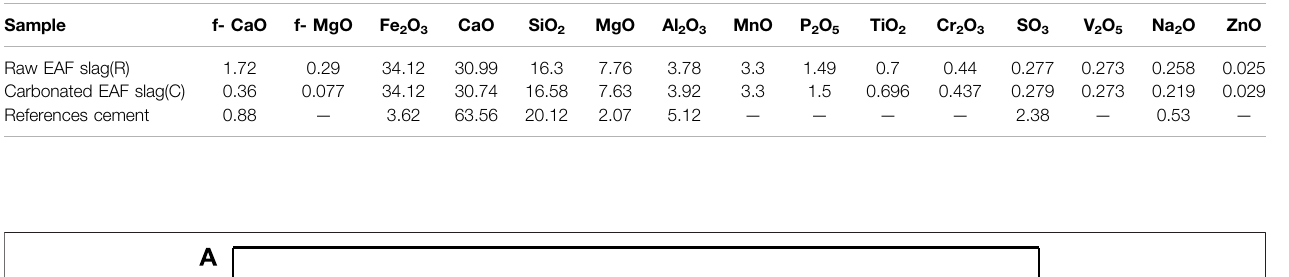
Frontiers in Energy Research |